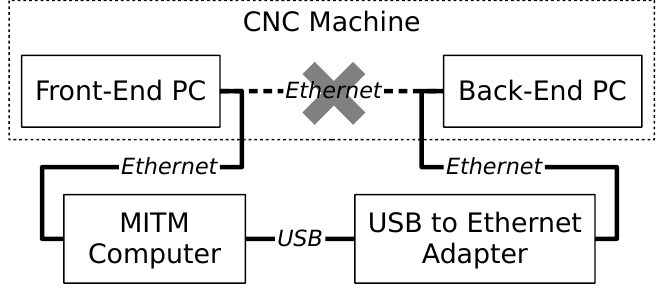
Figure 2. MITM physical connection